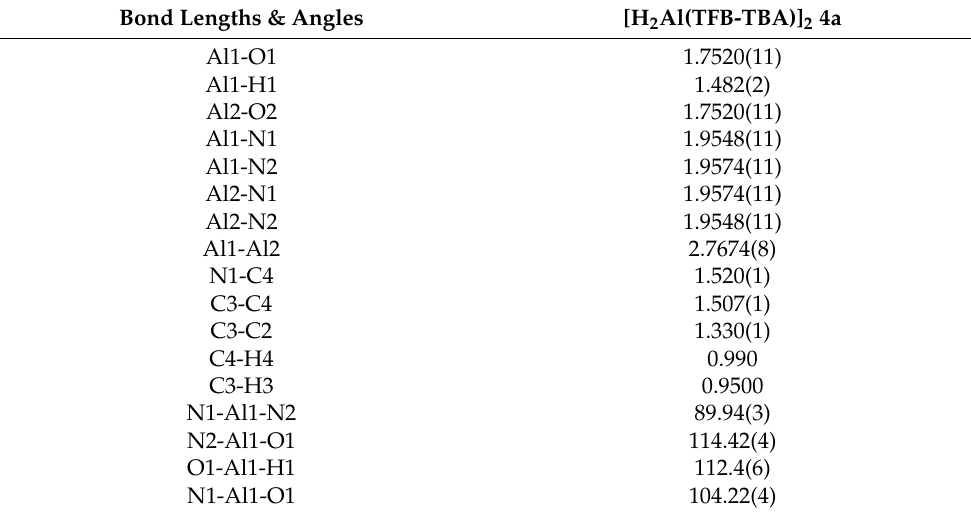
Table 2. Selected bond lengths (Å) and angles ( ◦ ) for compound [H 2 Al(TFB-TBA)] 2 4a